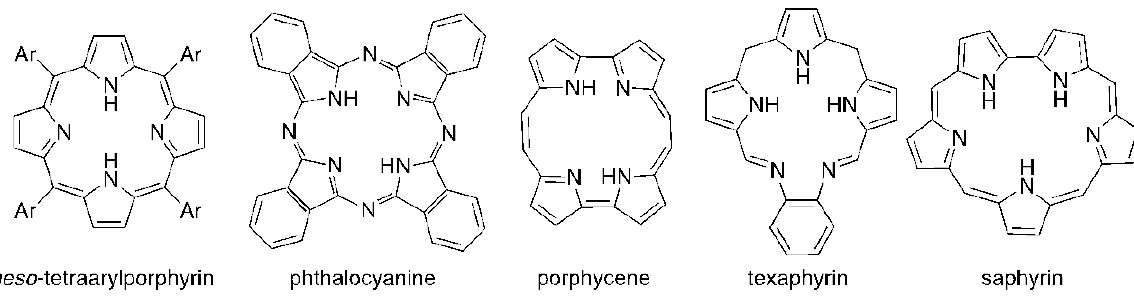
Figure 2. Skeletons of some synthetic pyrrolic macrocycles used as photosensitizers.